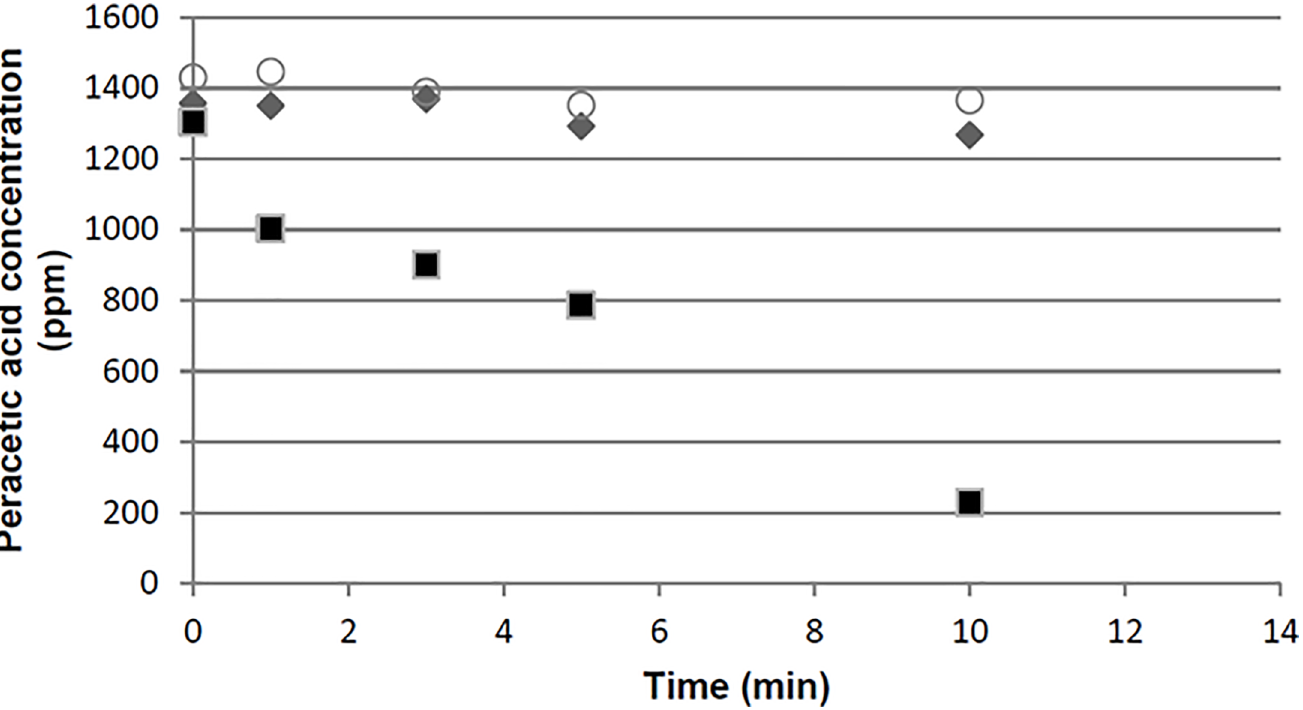
Fig 2. Changes in peraceticacid concentration when exposed to AISI types 304 ( ◆ ) or AISI 430 ( ■ ) stainless steel carrierscontaining dried-on phosphate buffered saline. PAA concentration at 0, 1, 3, 5, 10 and 15 minutes provide control ( (cid:14) ) points.